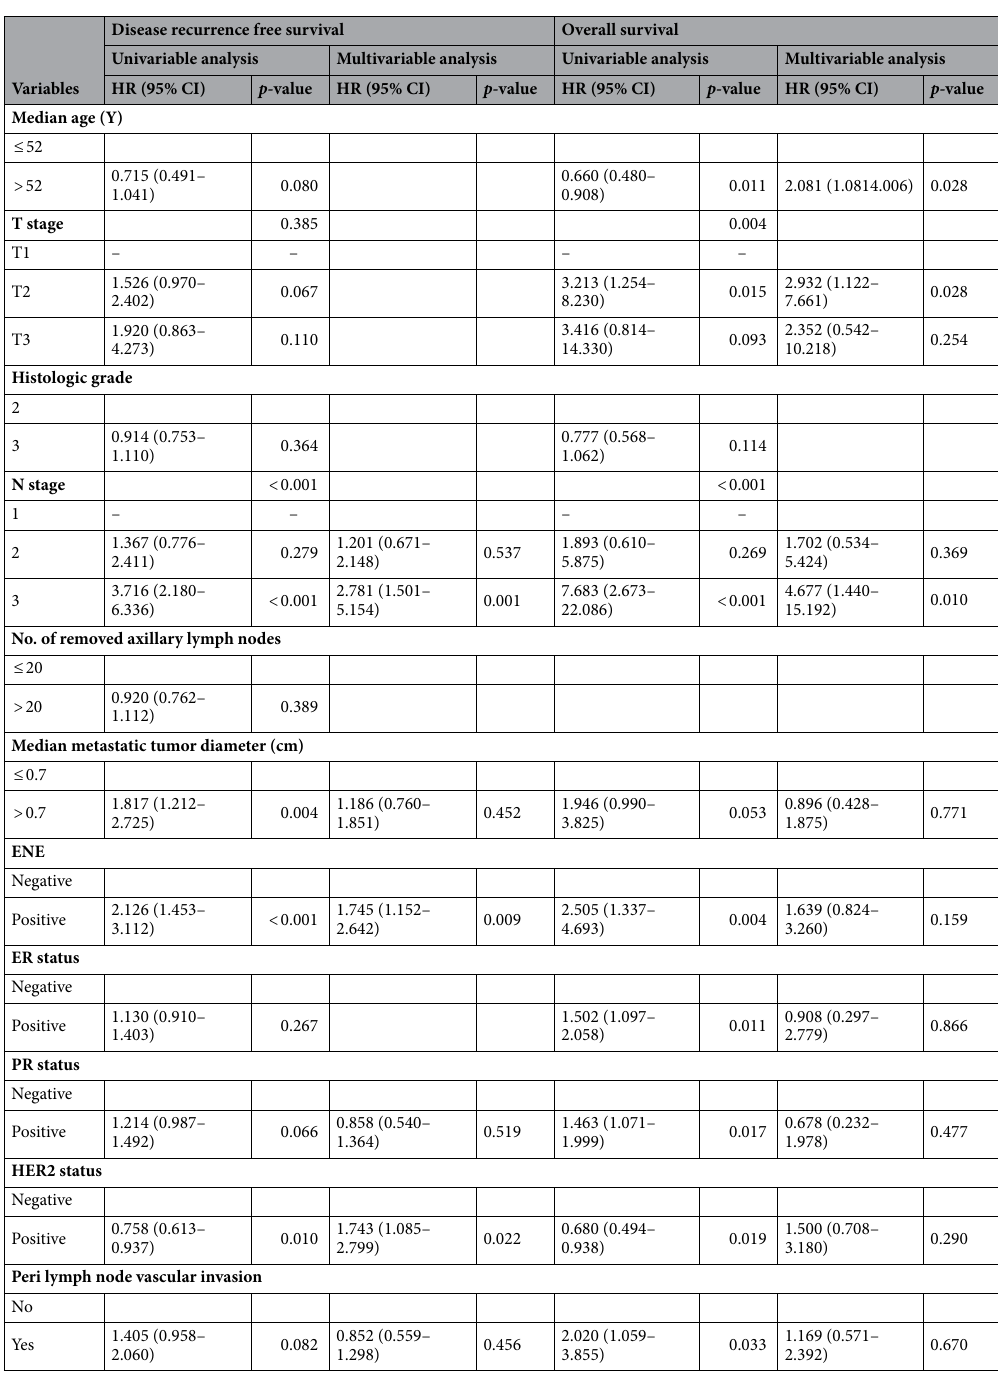
Table 4. Correlations between ENE in ALN and DRFS and OS. ER estrogen receptor; PR progesterone receptor; HER2 human epidermal growth factor receptor 2; ENE extranodal